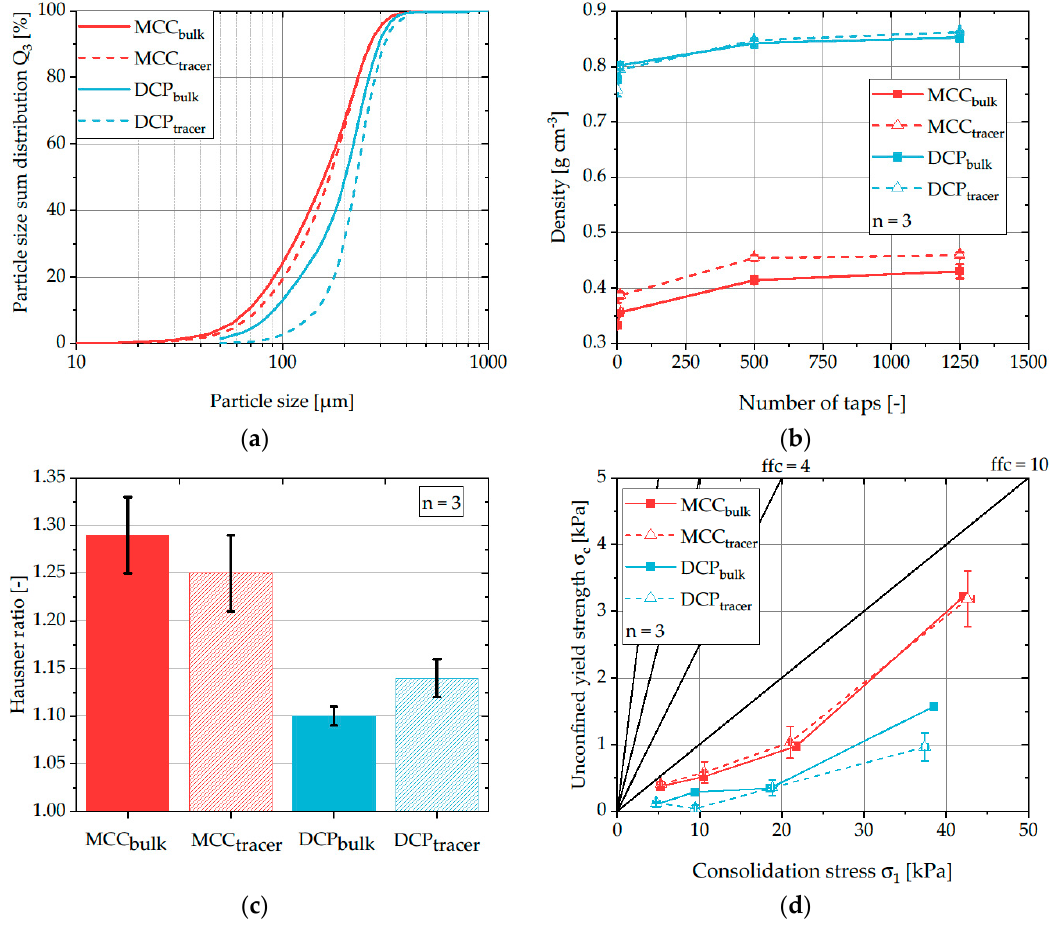
Figure 4. Particle size sum distributions ( a ), bulk and tapped densities ( b ), Hausner ratios ( c ), and ring shear cell results ( d ) of bulk and tracer powder. Symbols represent mean and error bars standard deviation.